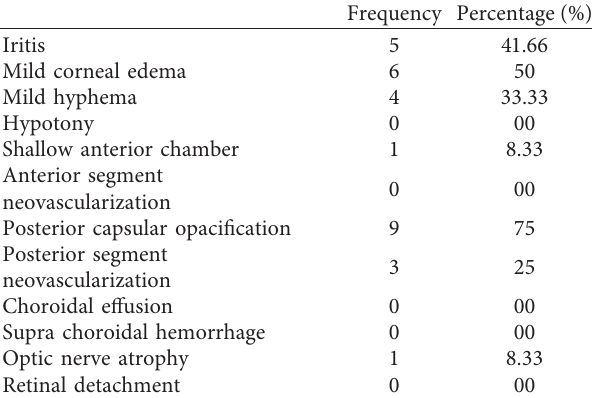
Table 6: Postoperative